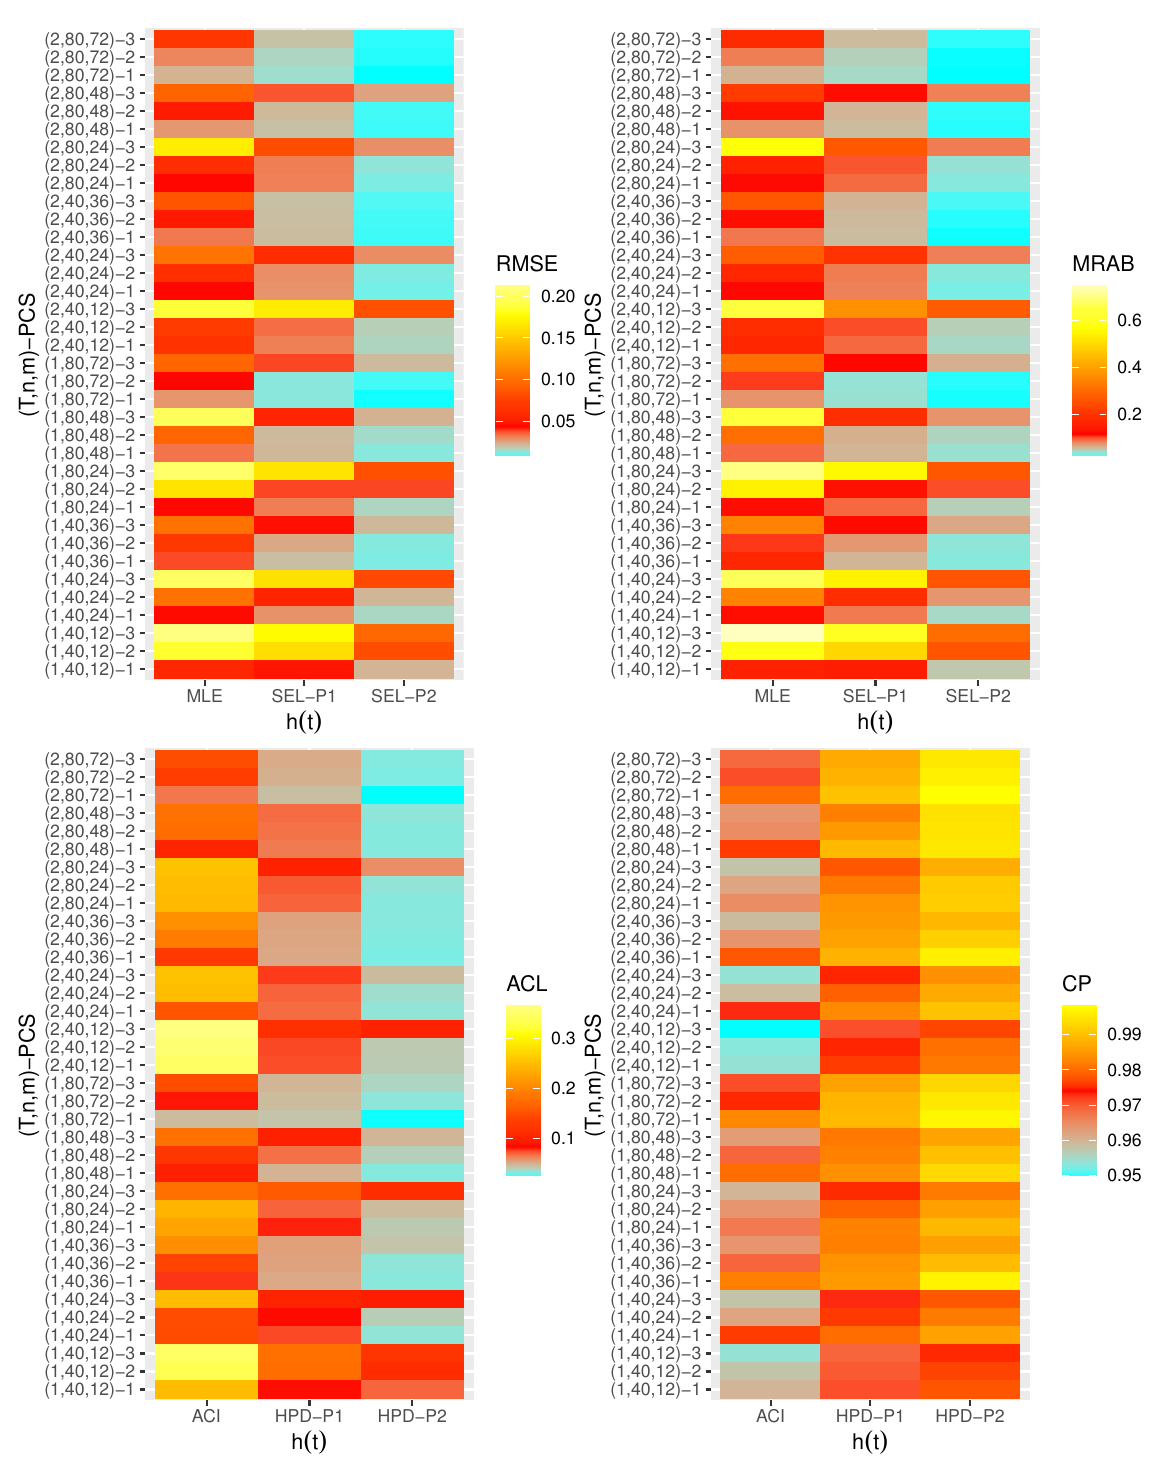
Figure 6. The heatmaps for the estimation results of h ( t ) when λ =